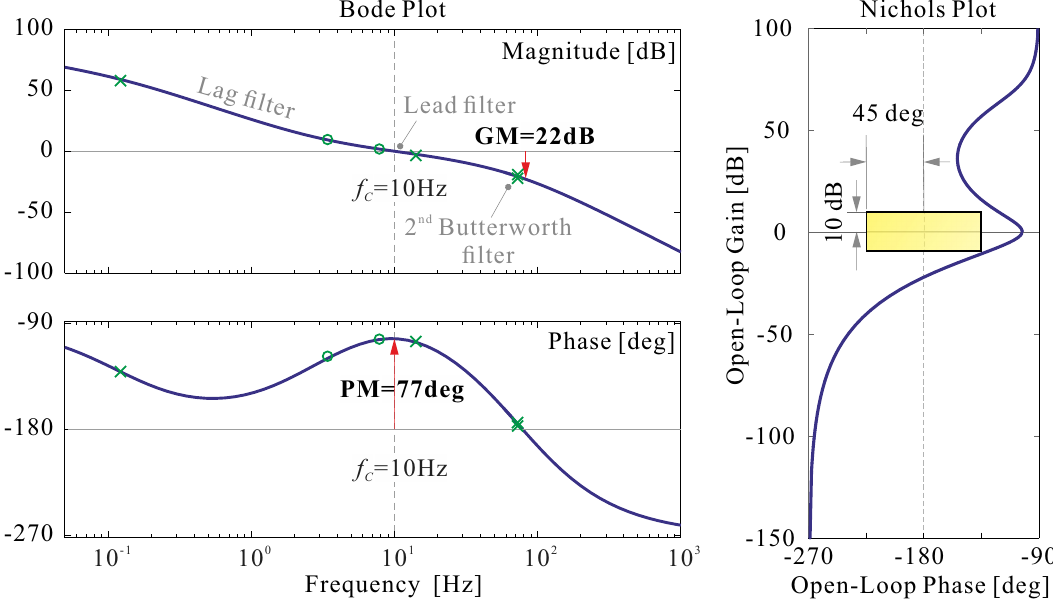
Figure 4. Compensator H ( s ) , normalized to f c = 10 Hz. It consists of an integrator, a lag filter, a lead filter, and a Butterworth second-order filter; the position of the poles and zeros are indicated on the Bode plots (left). The bandwidth may be adjusted by translating the Bode plots along the frequency axis until the proper crossover frequency f c is reached. This leaves the Nichols plot (right)